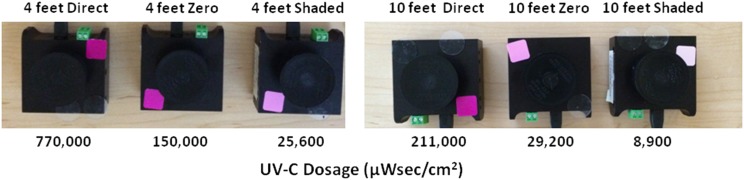
Results obtained with qualitative photochromic dosage indicator labels (red, pink, and white rectangles attached to sensors) and dosages (µWsec/cm
2
) measured using radiometric ultraviolet C (UV-C) light sensors placed at various distances from and orientations relative to the UV device after a 15-minute cycle. UV-C light normally enters the radiometric sensors through openings that were covered by circular elevated caps at the time photographs were taken.